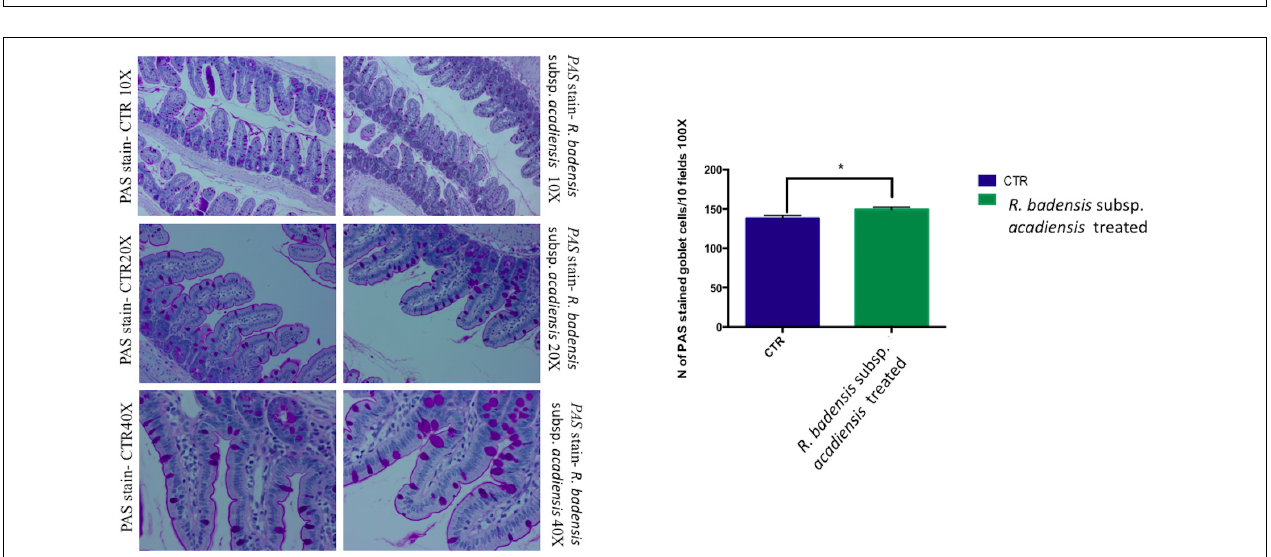
FIGURE 5 | Mean ± SEM of the number of IL10 positive cells populations in 10 fields of objective 100X in the ileum of mice fed 1% sucrose (CTR) or R. badensis subsp. acadiensis fed 10 8 CFU/mouse/day for 7 days. Significant difference exists if * p < 0.05- p is < 0.001 representative tissue photos of IL10 positive cells in the lamina propria are taken with 10 × , 20 × , and 40 × magnifications.